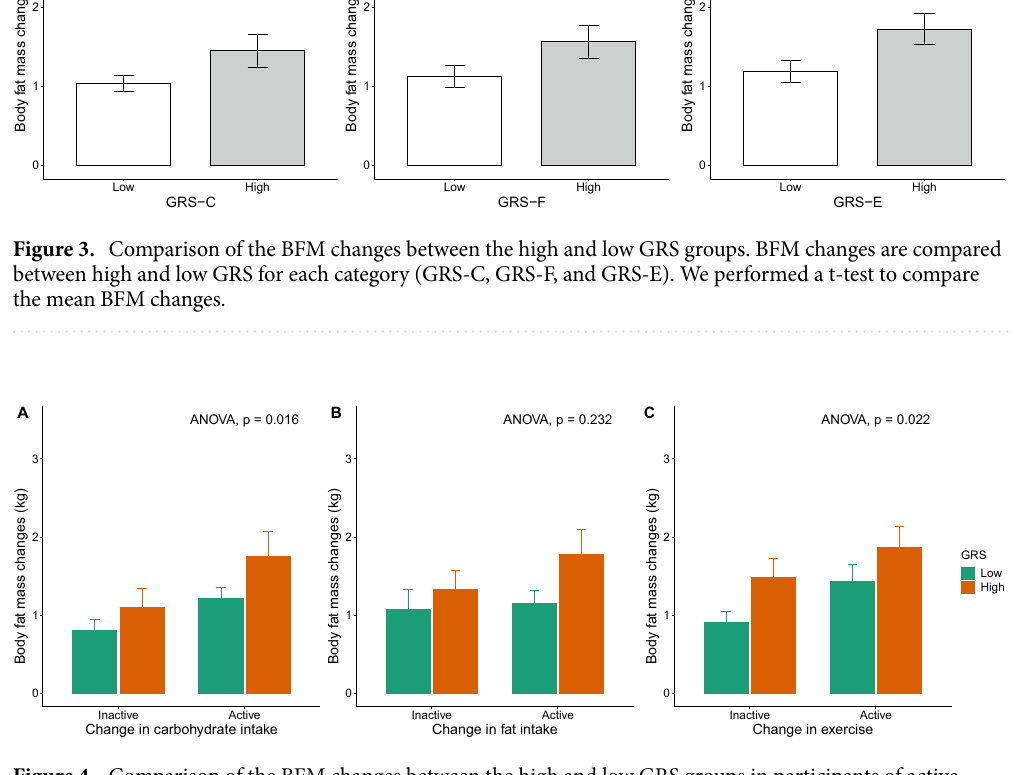
Figure 4. Comparison of the BFM changes between the high and low GRS groups in participants of active and inactive GRS-matched lifestyle change. To better understand GRS efficiency, BFM changes were compared between the active and inactive lifestyle changes. Each extent of the lifestyle changes was compared based on each GRS